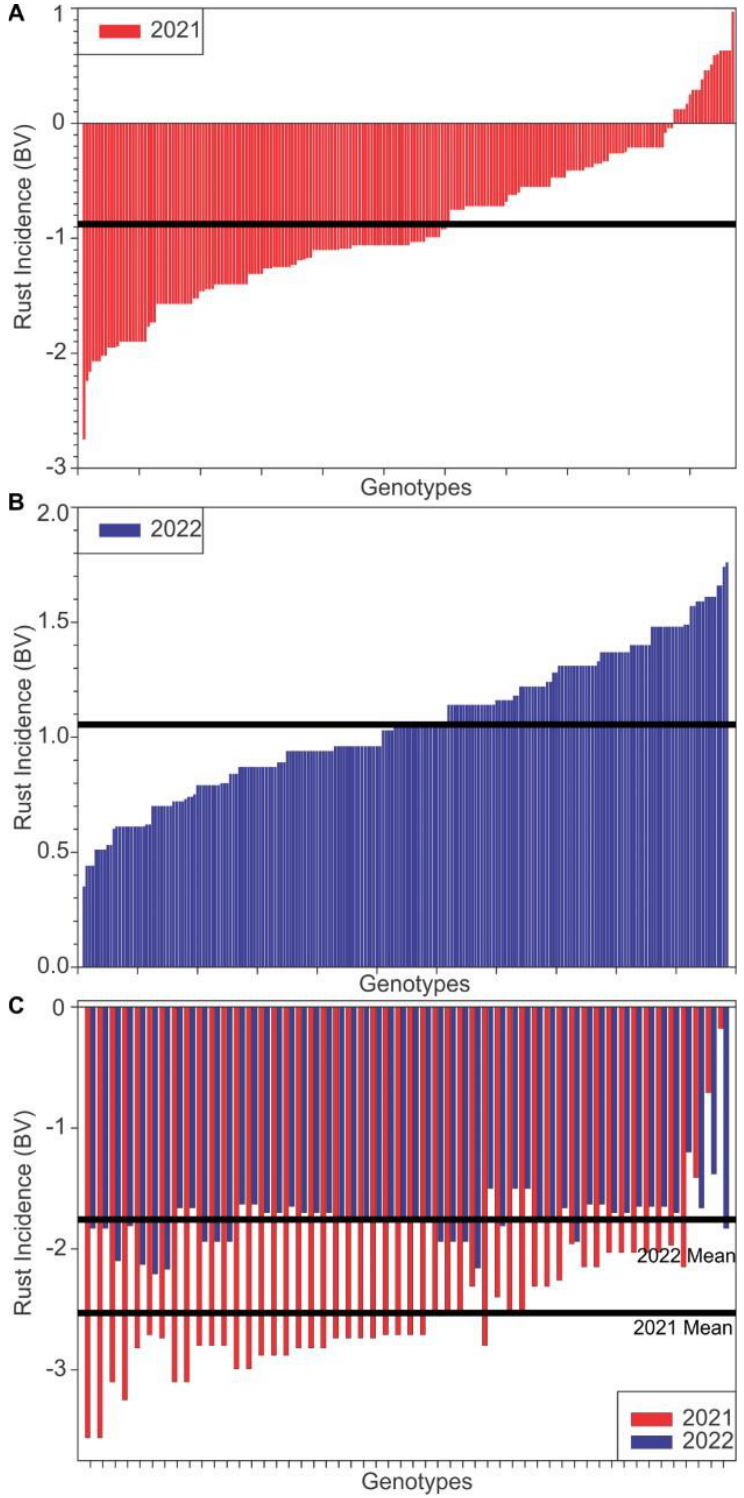
Figure 1. Distributions of breeding values for natural rust incidences predicted on two generations of a Summer × Kanlow switchgrass population. ( A ) Mapping population tested in 2021. ( B ) Mapping population tested in 2022. ( C ) Kanlow population tested in 2021 (blue bars) and 2022 (red bars). The horizontal bars represent the means of the populations. Families and progeny were rated on a 0–4 scale in a field, near Mead,